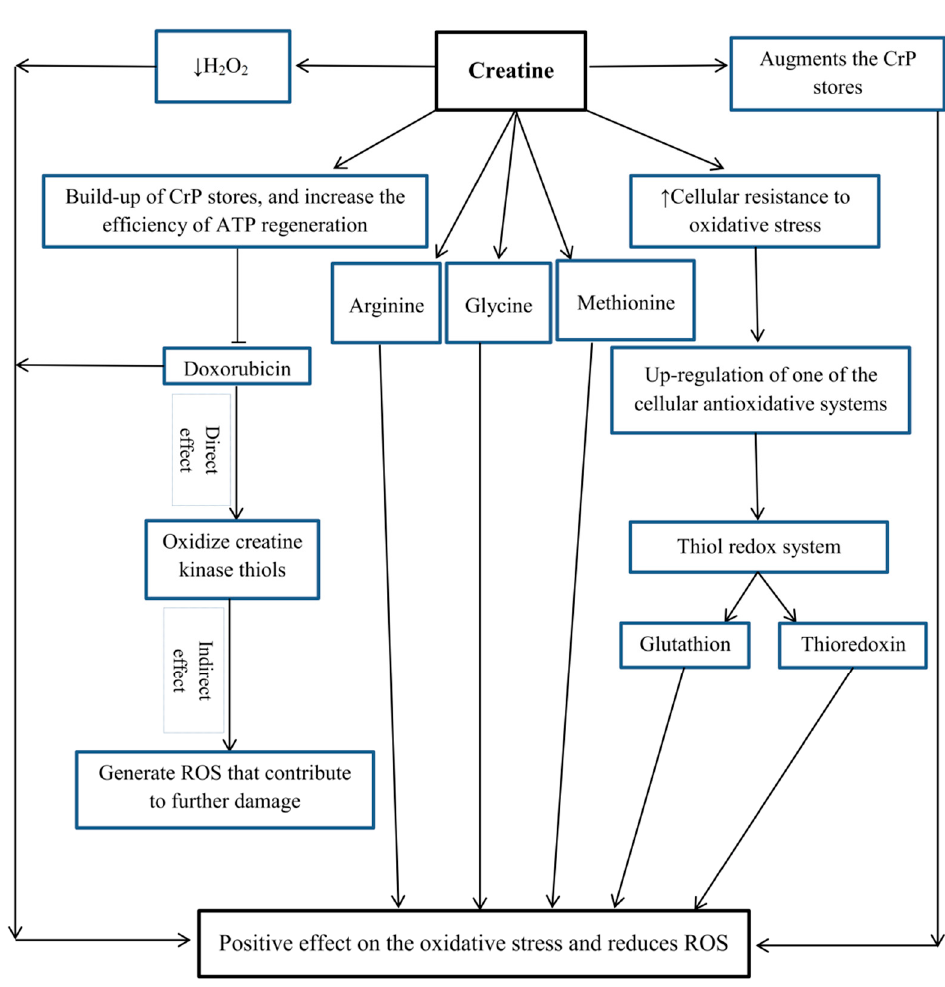
Figure 3. The effect of creatine on oxidative stress. Hydrogen peroxide (H 2 O 2 ); creatine phosphate (CrP); adenosine triphosphate (ATP); and reactive oxygen species (ROS).